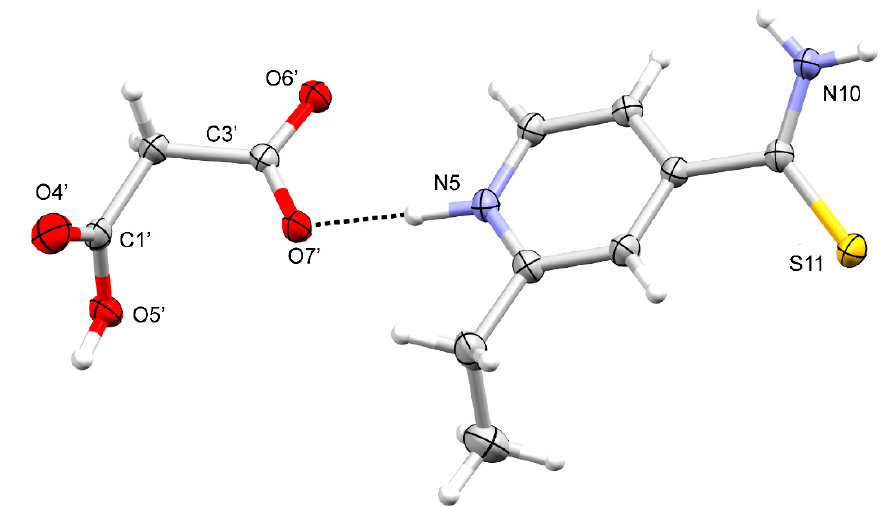
Figure 3. Asymmetric unit of ETN-MAL.